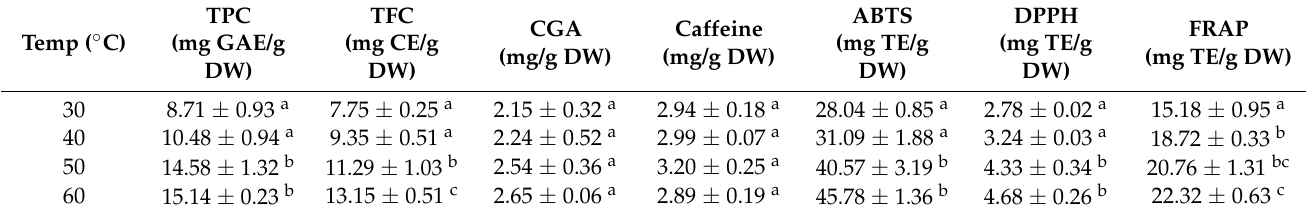
Table 2. Effect of temperature on recovery of bioactive compounds and antioxidant from coffee pulp.